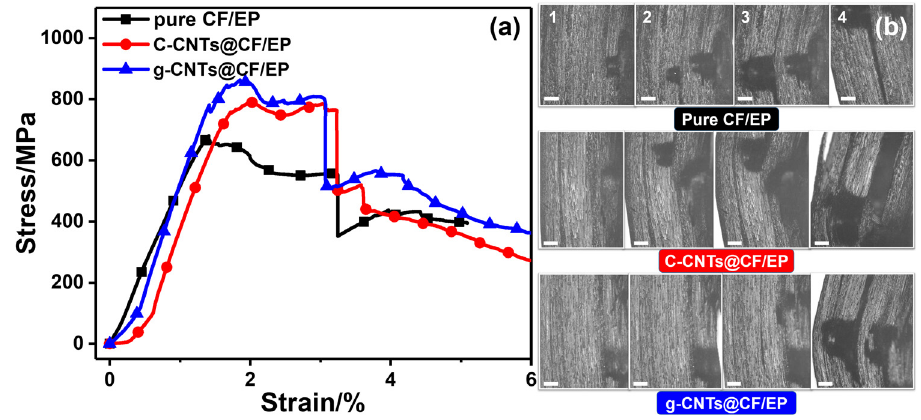
Figure 8: Flexural stress – strain curves of in situ bending test ( a ) and optical microscopic images of pure CF/EP, C - CNTs@CF/EP, and g - CNTs@CF/EP composites via the fi ber enhancement method ( b ) . The scale bar is